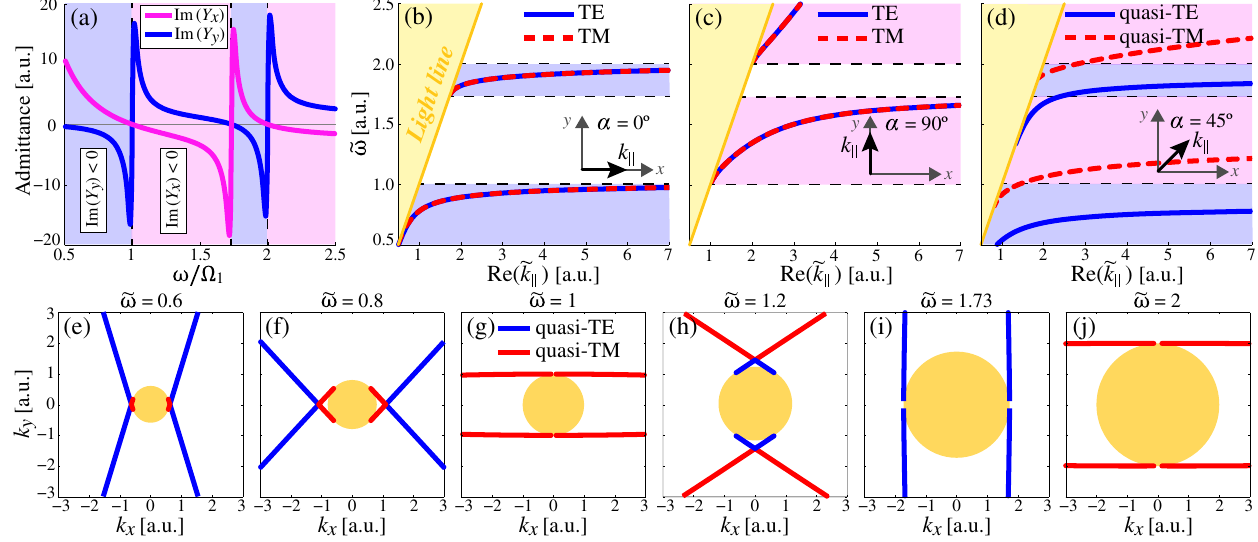
˜ Ω ¼ 1 , N ¼ 0 . 5 , ˜ Ω ¼ 2 , 1 2 2 ¼ ˜ k α ; k ¼ ˜ k α Þ space at the k cos k sin x y